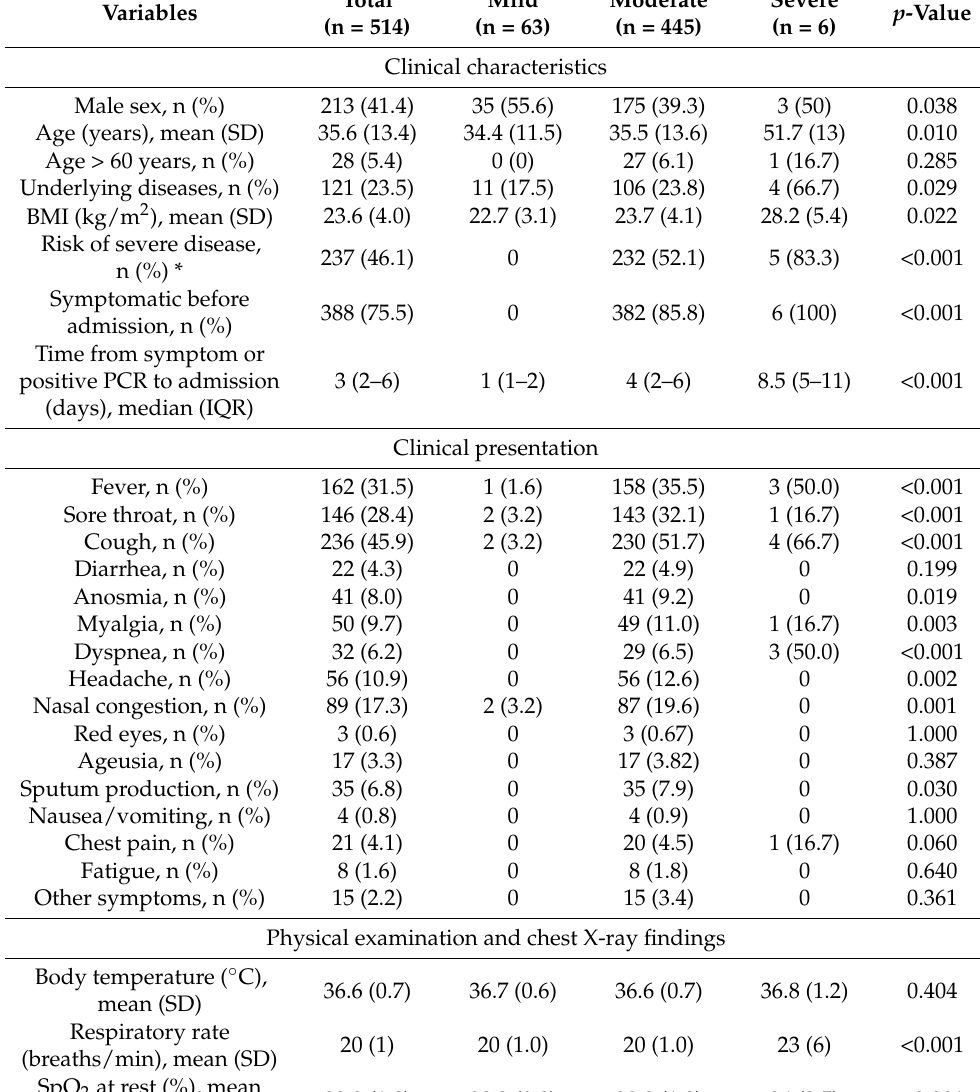
Table 1. Baseline characteristics and clinical presentation of 514